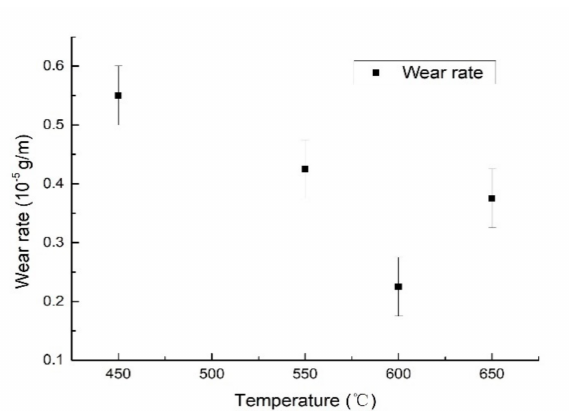
Figure 17. E ff ect of sintering temperature on the wear rate of AA6061 / 5 vol.% N-SiCp under 4.5 Figure 17. Effect of sintering temperature on the wear rate of AA6061/5 vol.% N-SiCp under 4.5 GPa.